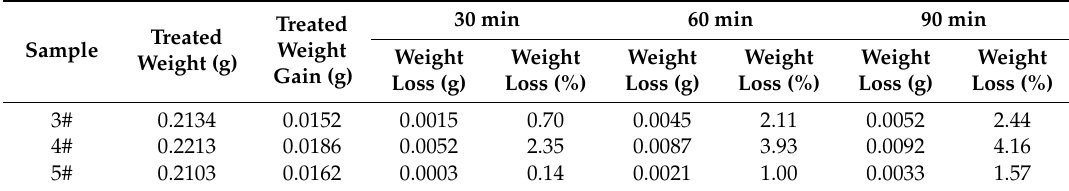
Table 2. Weight change for the different washing